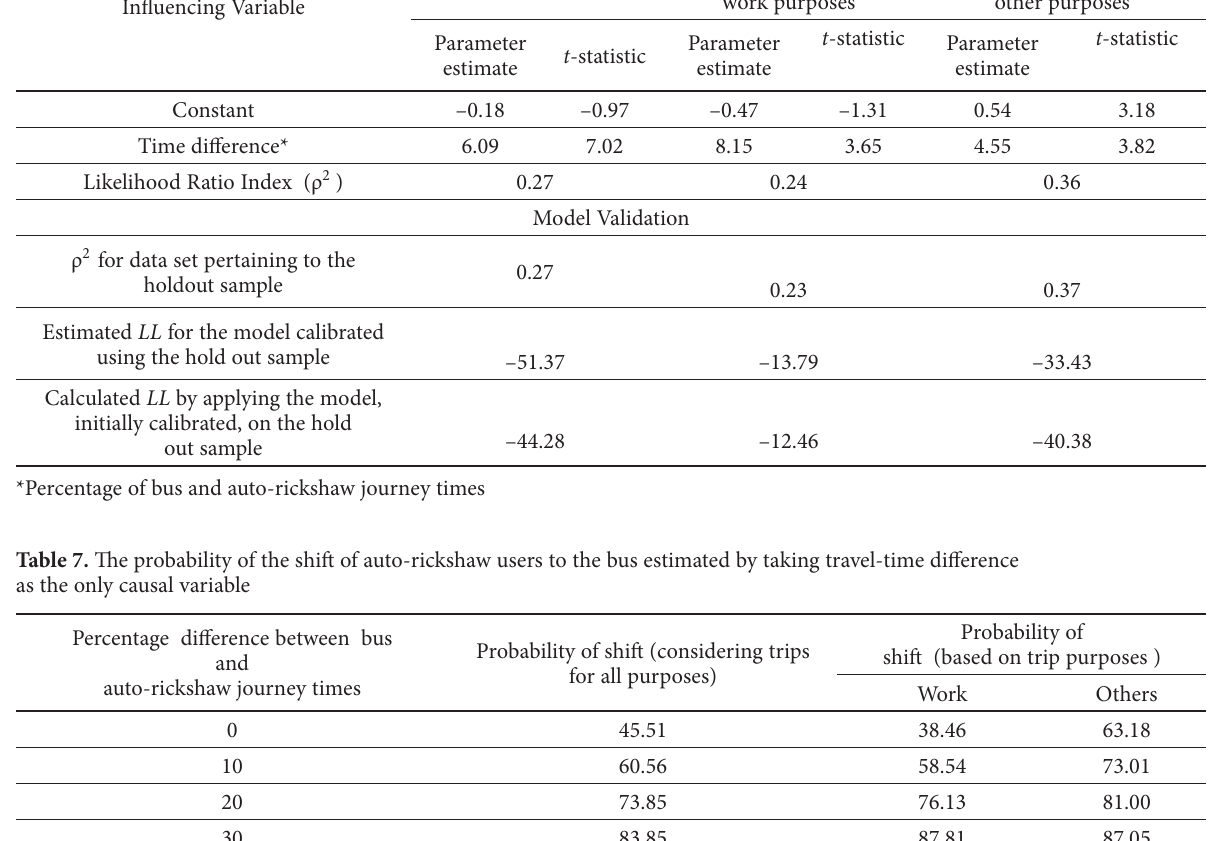
Infl uencing Variable